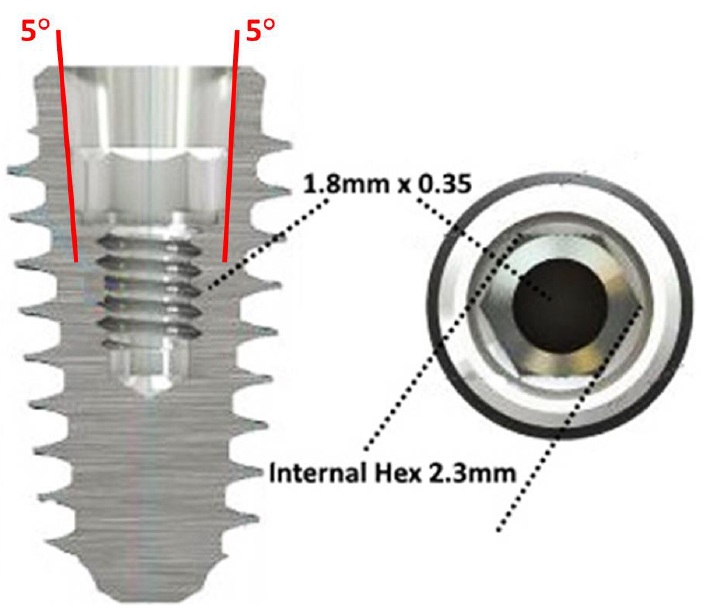
Figure 1. Schematic view of the implant system adopted in this study. Details of the 5 degree internal tapered IAI (implant abutment interface) are shown: the internal hexagon index was 2.3 mm wide, while the internal screw canal measured 1.8 × 3.5 mm.